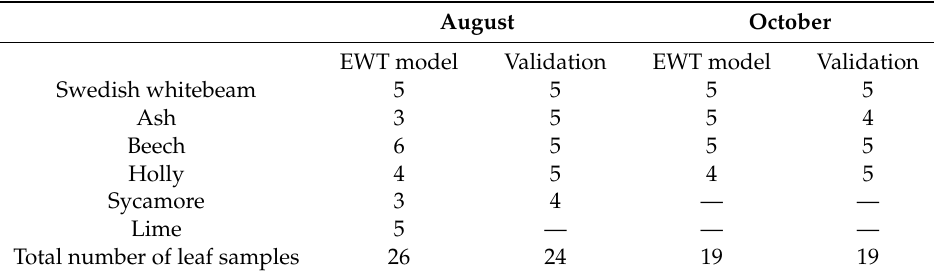
Table 3. Number of leaf samples collected in the August and October